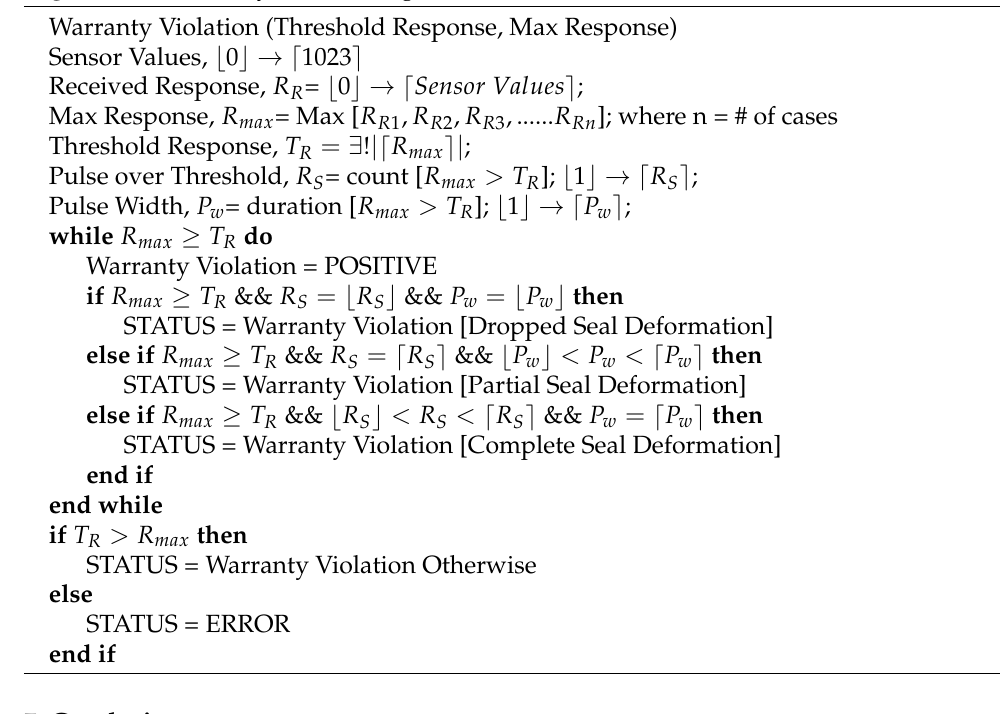
Algorithm 1 Warranty violation